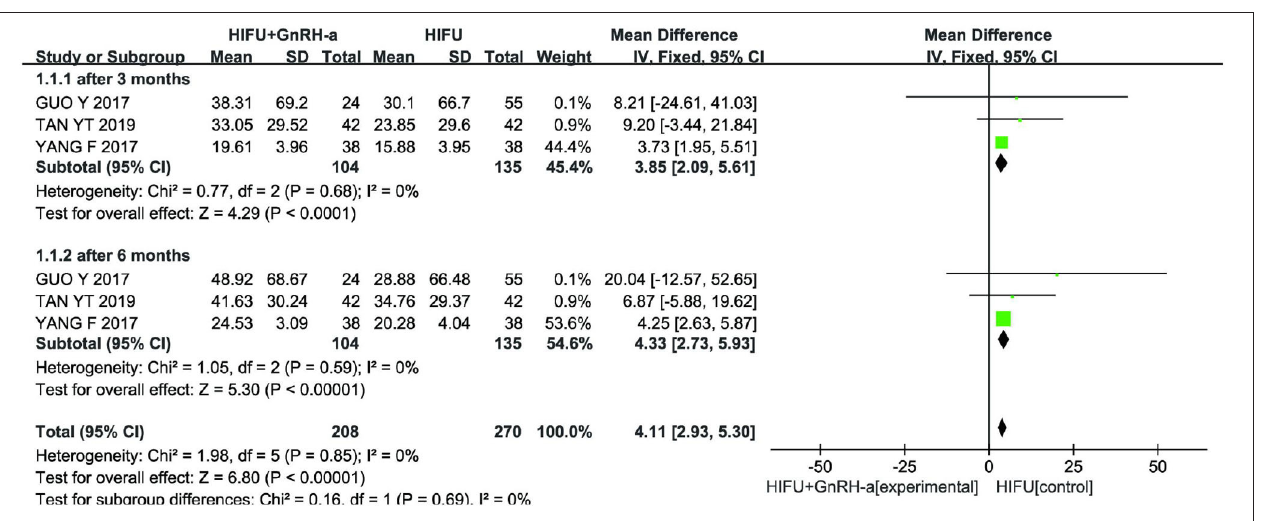
FIGURE 5 | Meta-analysis of lesion volume changes in two